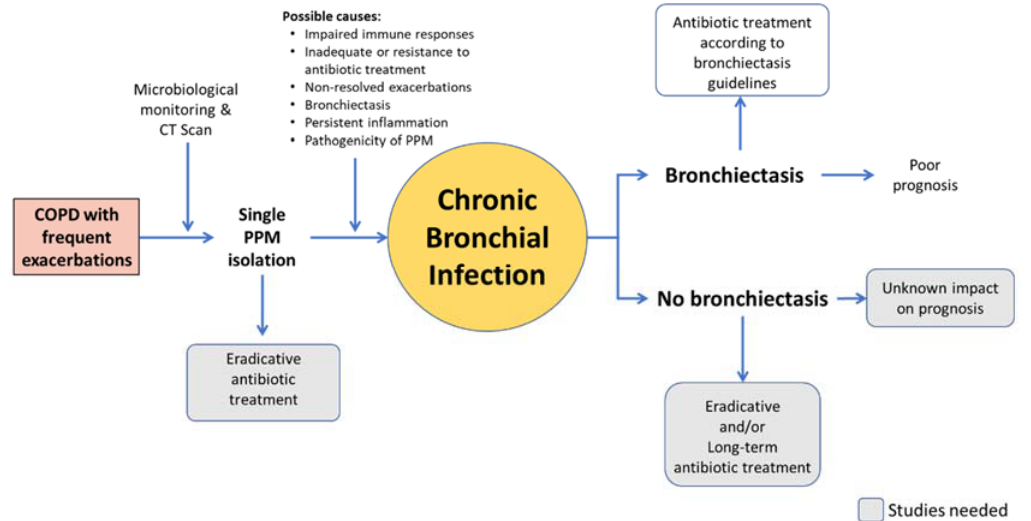
Figure 2. Areas of controversy about long ‐ term antibiotic therapy in COPD.